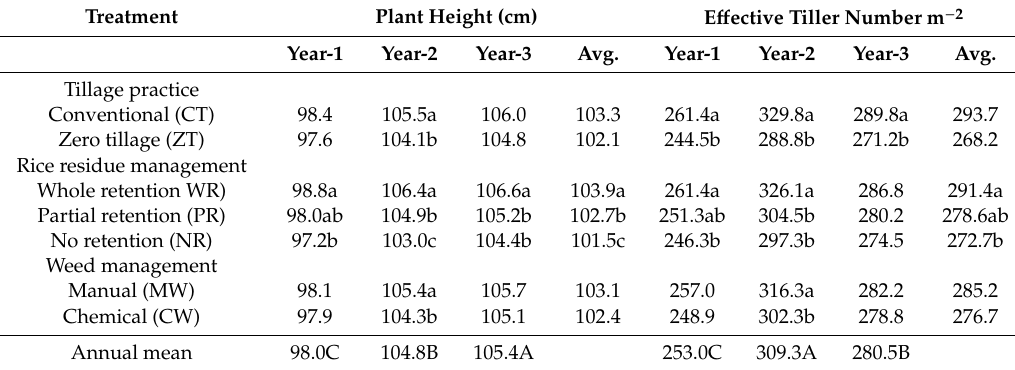
Table 2. E ff ects of di ff erent tillage, crop residue and weeding management on plant height and tiller numbers of rice. Di ff erent lowercase letters within a column indicate significant di ff erence with a treatment. Di ff erent uppercase letter within a row for annual mean values (last row) indicate significant di ff erence among the study